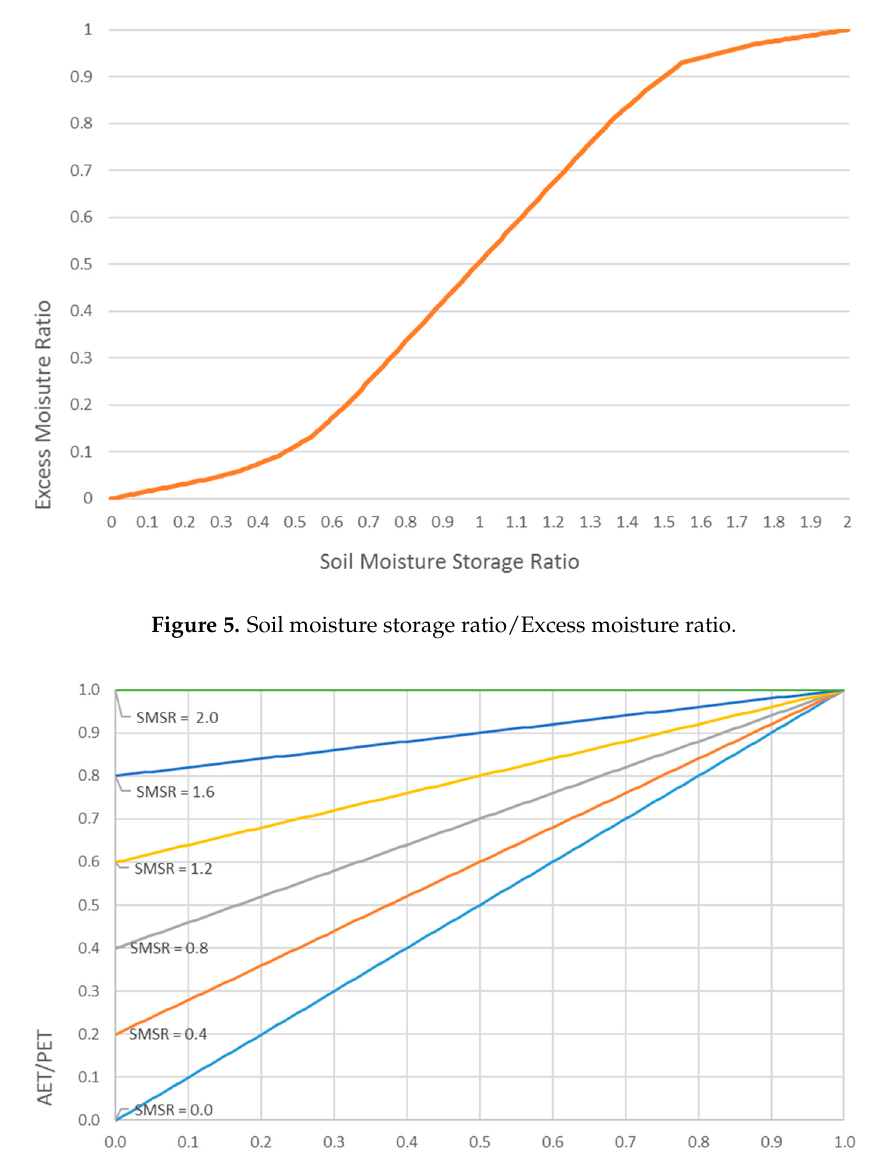
Figure 6. Actual evapotranspiration (AET)/potential evapotranspiration (PET) ratio as function of precipitation (P)/PET and soil moisture storage ratio (SMSR).